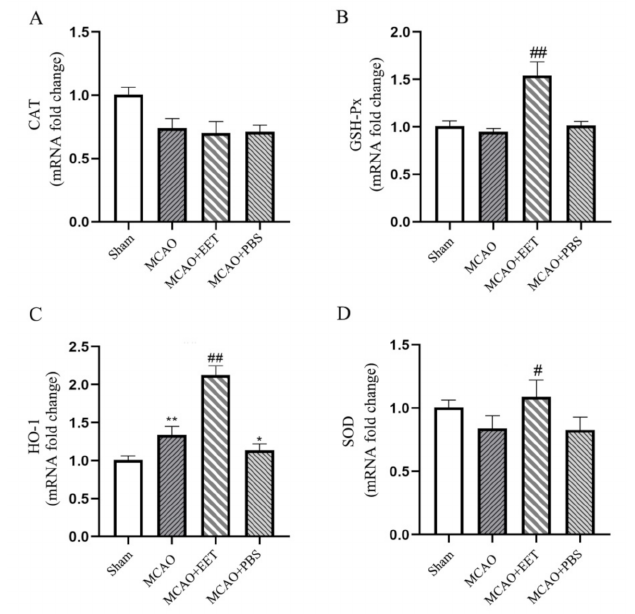
Figure 7. The antioxidant gene expression was detected by qPCR method in brain tissue at 22 h after middle cerebral artery occlusion and reperfusion. ( A ) Catalase. ( B ) Glutathione peroxidase. ( C ) Heme oxygenase-1. ( D ) Superoxide dismutase. (* p < 0.05, ** p < 0.01 vs. sham; # p < 0.05, ## p < 0.01 vs. MCAO; n =